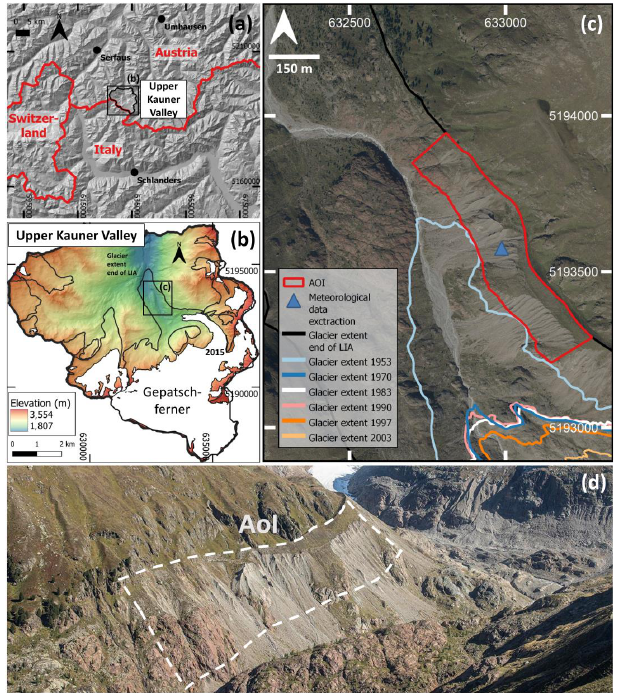
Figure 1. ( a ) Location of the study area in the upper Kauner Valley (Tyrol, Austria) with ( b ) the location of the proglacial area of Gepatschferner. ( c ) AoI (red) in the proglacial area of Gepatschferner in the upper Kauner Valley with glacier extents in different years and ( d ) course mapping of the AoI in a photo (white dashed line) from 2021 (taken by Anton Brandl). Sources of glacier extents: End of LIA: Groß and Patzelt [40], 1953 to 2003: Own mapping by change detection based on DoDs published by Piermattei et al. [20] (mapping method also includes mapping of debris-covered glacier parts), 2015: Buckel and Otto [41]. Large-scale elevation data (DSM, 25 m) ( top left ) are based on SRTM and ASTER GDEM [42]. DEM 2017 (1 m) ( bottom left ) based on Airborne LiDAR data [4]. The 2020 orthophoto ( right ) is from the Province of Tyrol (see Appendix A, Table A1).